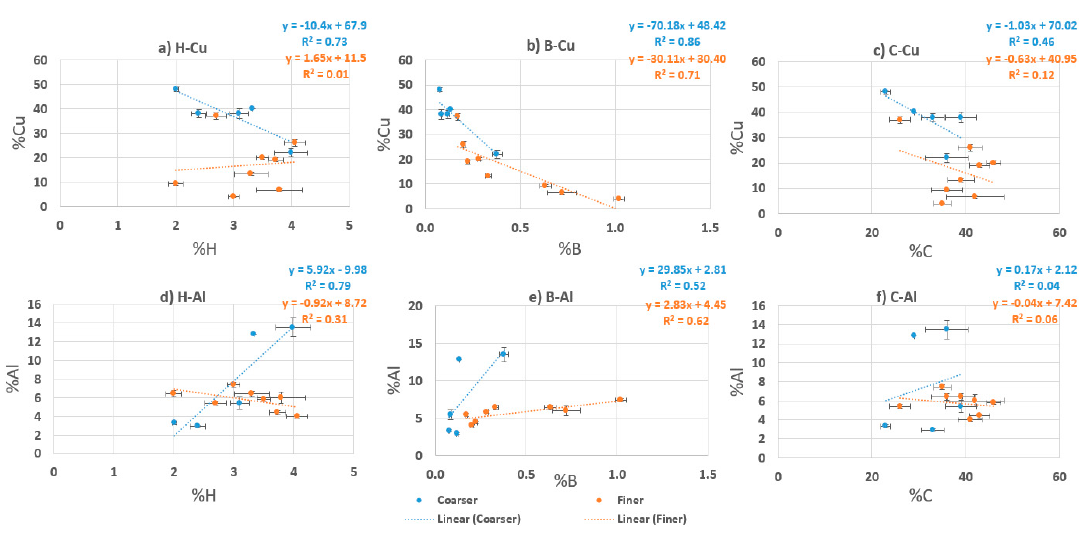
Figure 2. Relationship between metallic elements and light elements measured by PGAA; ( a – c ) light elements vs. Cu ( d – f ) light elements vs. Al.